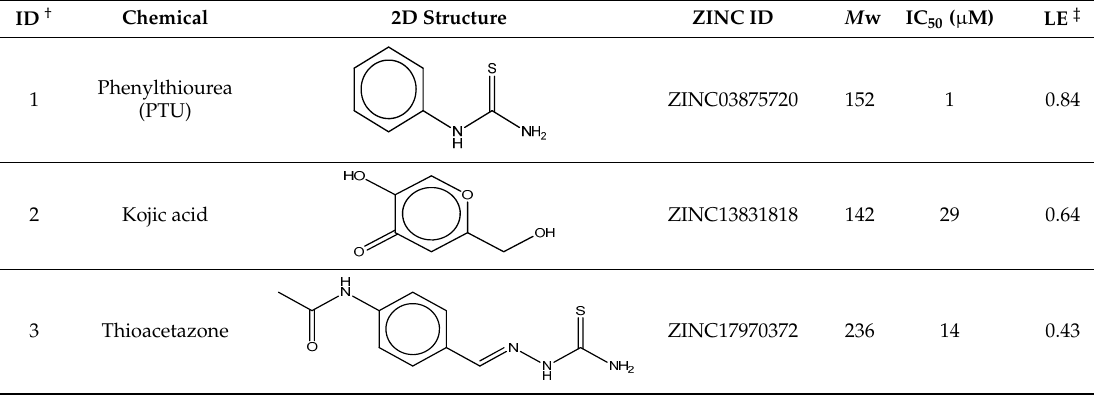
Figure 1. Profiles of concentration dependent inhibition of tyrosinase by thiourea and its analogues. Each inhibitory activity was scaled with that in the absence of inhibitor as 1. Table 1. Details of the compounds tested in this study for the inhibition of mushroom tyrosinase.